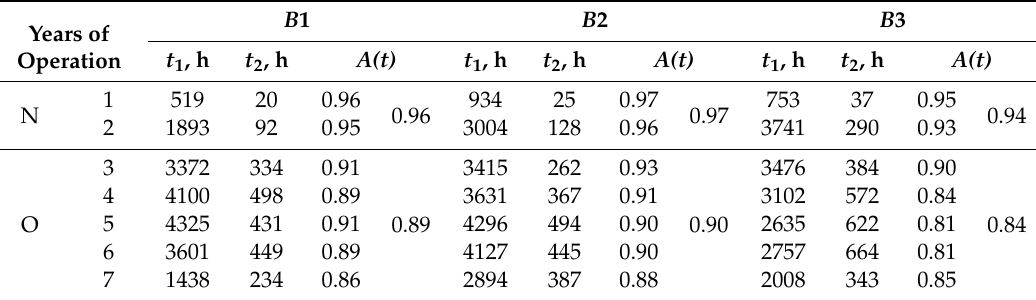
Table 3. Availability of analyzed machines.